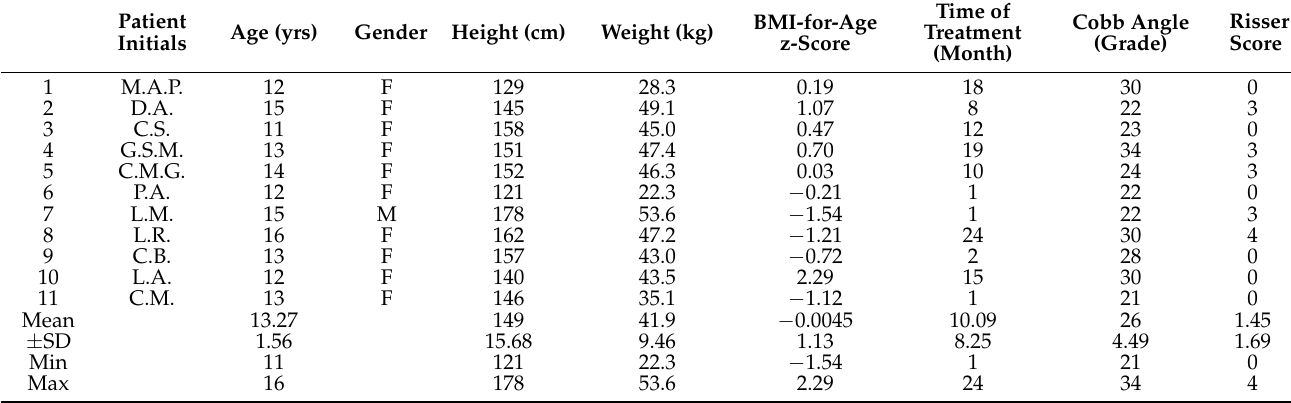
Table 1. Vital statistics of study subjects. BMI = body mass index; F = female; M = male; SD = standard deviation; Min = minimum: Max = maximum. Note that arm-span was used as a surrogate of height. Patient